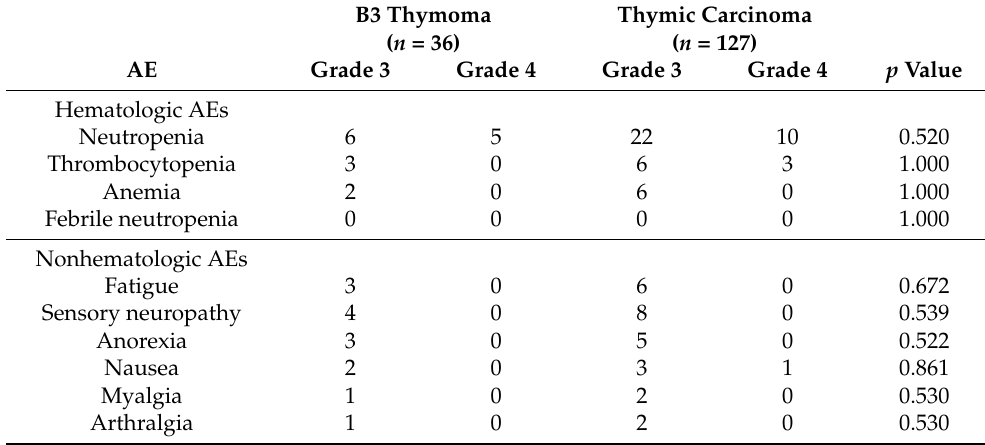
Table 3. Most common Treatment-Related Grade ≥ 3AEs According to